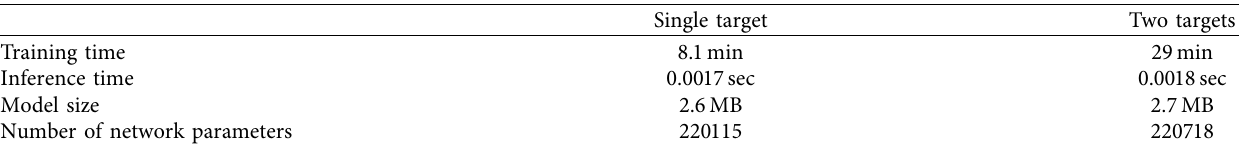
Table 3: Information of training time, inference time of one input, model size, and number of network parameters for both single and two targets.